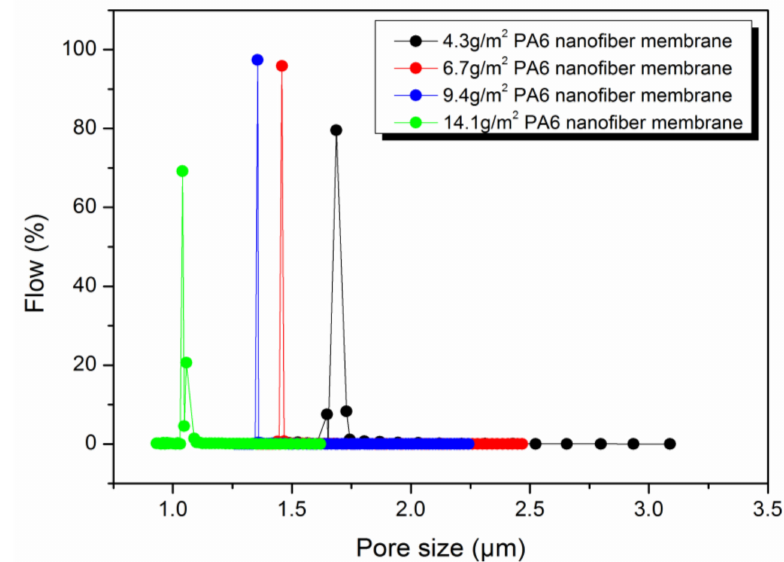
Figure 7. Pore size distribution of different areal densities of